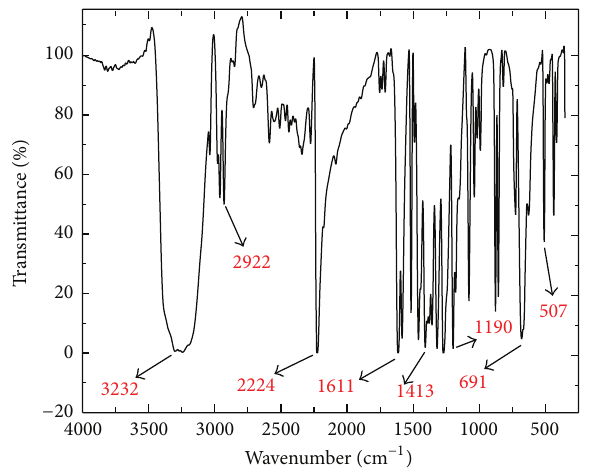
Figure 3: FTIR spectrum of 4-hydroxy-2,5-dimethylbenzonitrile.